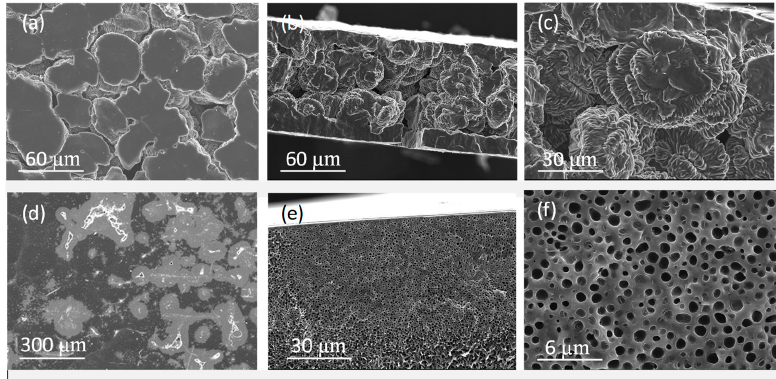
Figure 3. SEM images of PIMs prepared by the solvent casting method. 70% TPU–30% Aliquat 336: surface ( a ), cross-section ( b and c ); 70% PCL–30% Aliquat 336: surface ( d ), and cross-section ( e and f ).